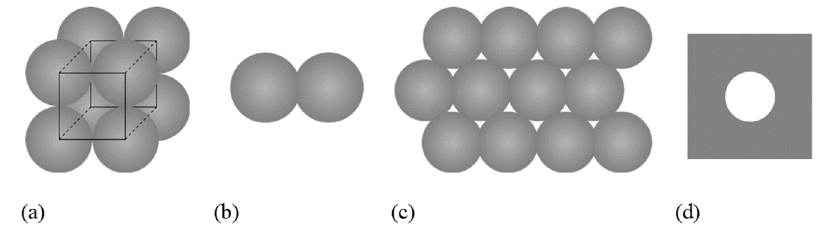
Figure 1. Schematic representation of coalescence of an array of spheres ( a ). In the first stage ( b ), the spherical particles coalesce and form trapped voids in between them ( c ). These voids become spherical and finally collapse ( d ).